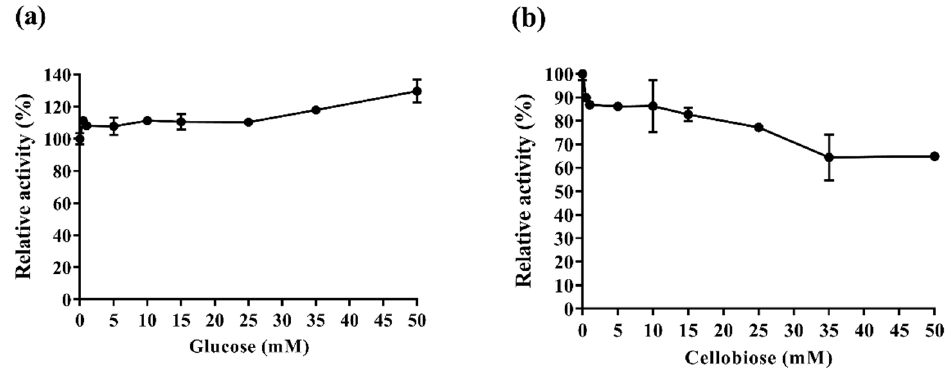
Figure 4. Glucose ( a ) and cellobiose ( b ) effect on Af-EGL7 activity. Error bars represent the standard deviation ( n = 3).